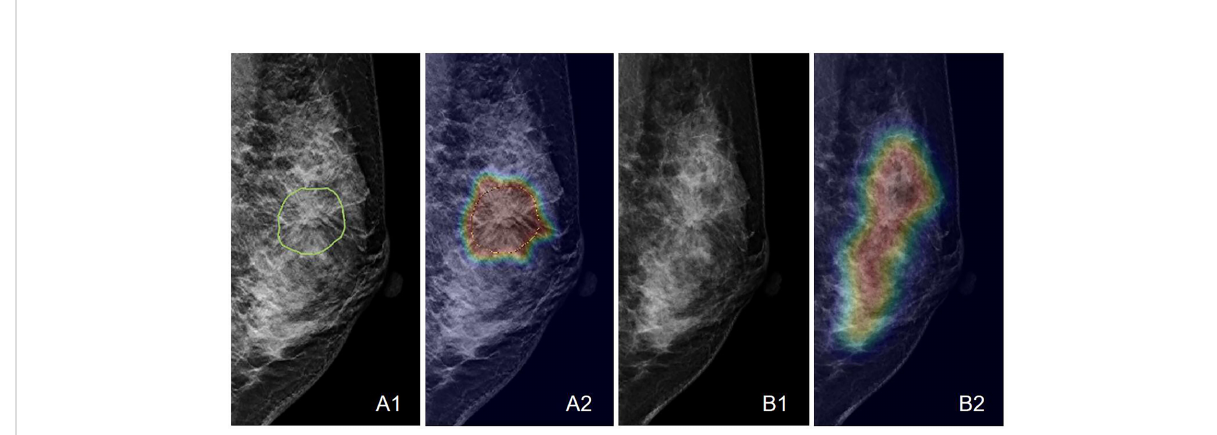
FIGURE 8 An example of the Grad-CAM map of the architectural distortion in the LMLO view of (A) DBT and (B) FFDM images of a 46-year-old patient diagnosed with adenosis. The BI-RADS score is 4B. The radiomics score is 0.41, and the deep learning probability is 0.38, both correctly diagnosing this case as benign. When the developed deep learning model from DBT is applied to FFDM, the probability is 0.48, which is also true-negative but reaches the threshold for malignancy. The detected suspicious area covers the entire dense tissues, showing the architectural distortion on FFDM cannot be